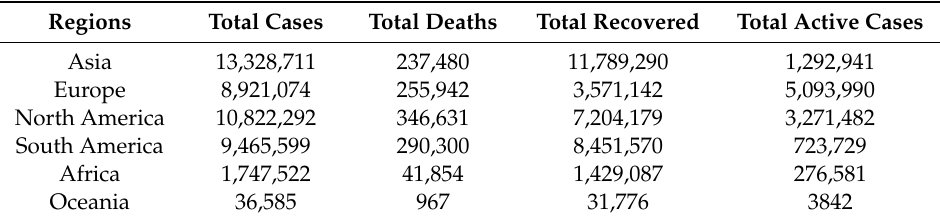
Table 1. Updated COVID-19 cases as of 28 October